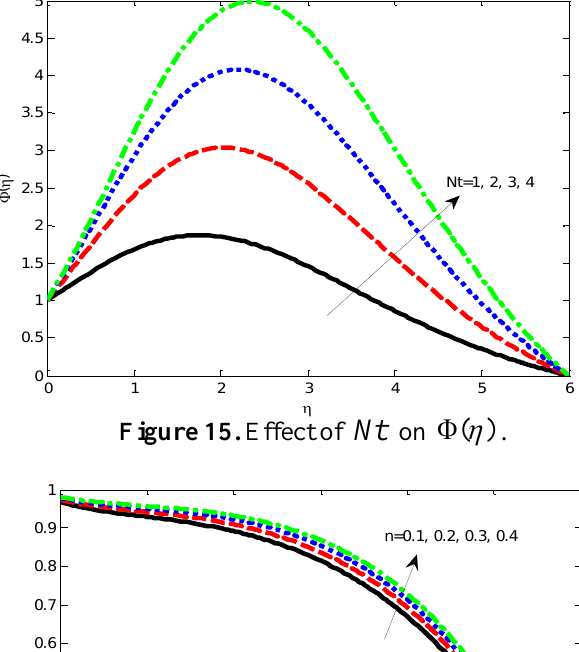
Figure 15. Effect of Nt on ( )  .